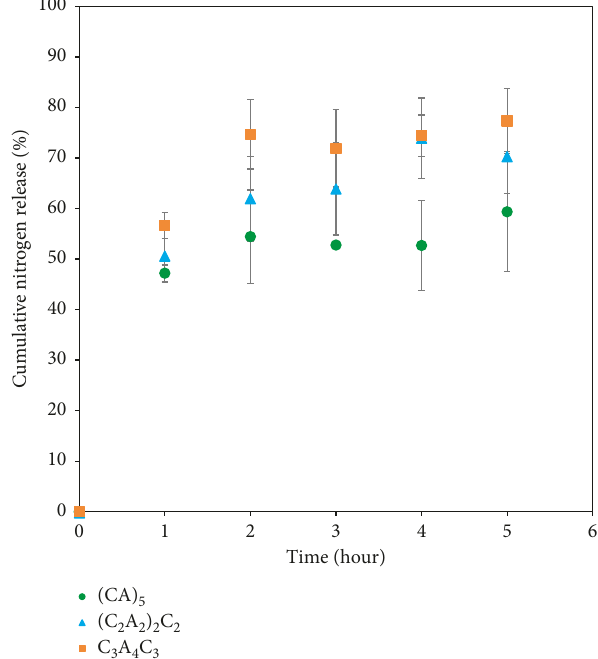
Figure 7: Effect of arrangement chitosan-alginate layer to the release of nitrogen.